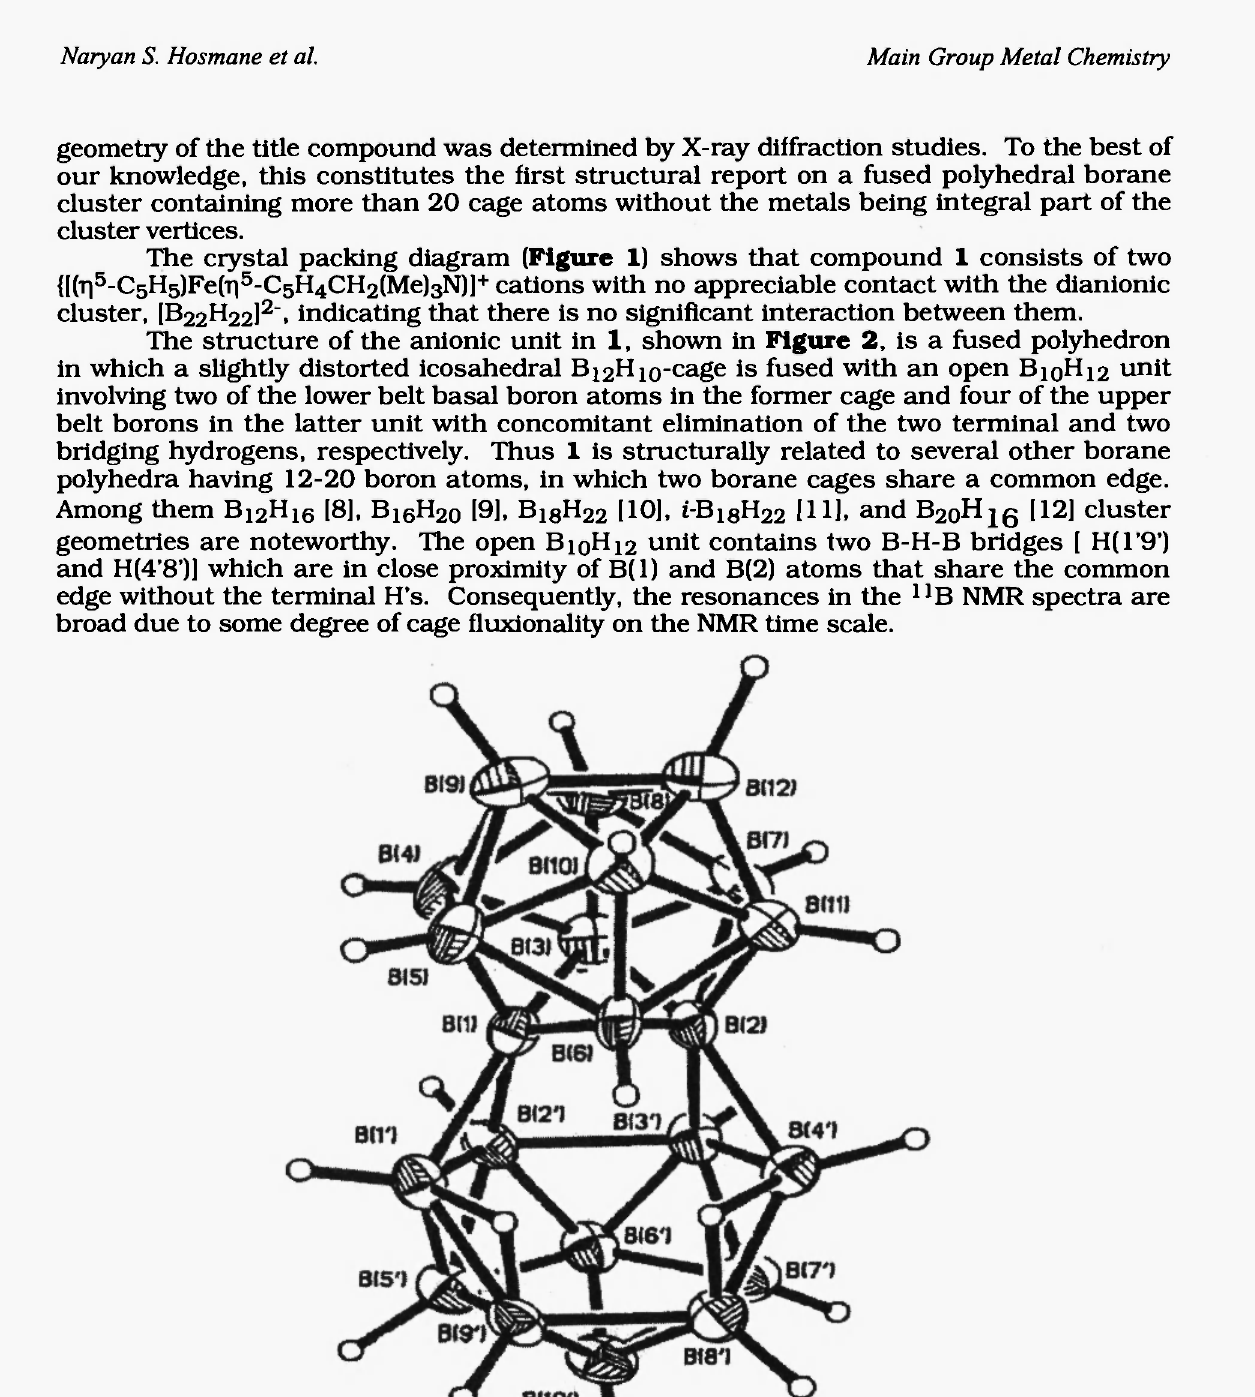
Figure 2. Perspective view of 1 with thermal ellipsoids drawn at the 40% probability level and showing the atom numbering scheme. The [^ 5 -C5H 5 )Fe^ 5 -C5H 4 CH2(Me) 3 N)] + cations are omitted for